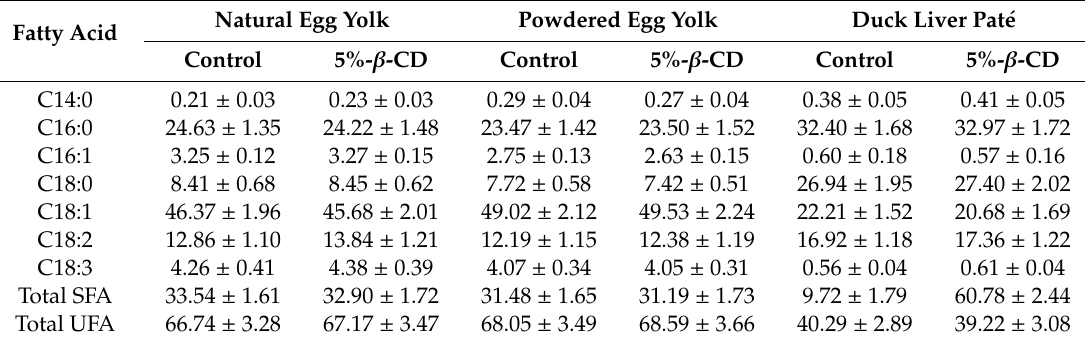
Table 2. Fatty acid (%) composition of natural egg yolk, powdered egg yolk, and duck liver p â t é from the control and those treated with 5% β -cyclodextrin ( β